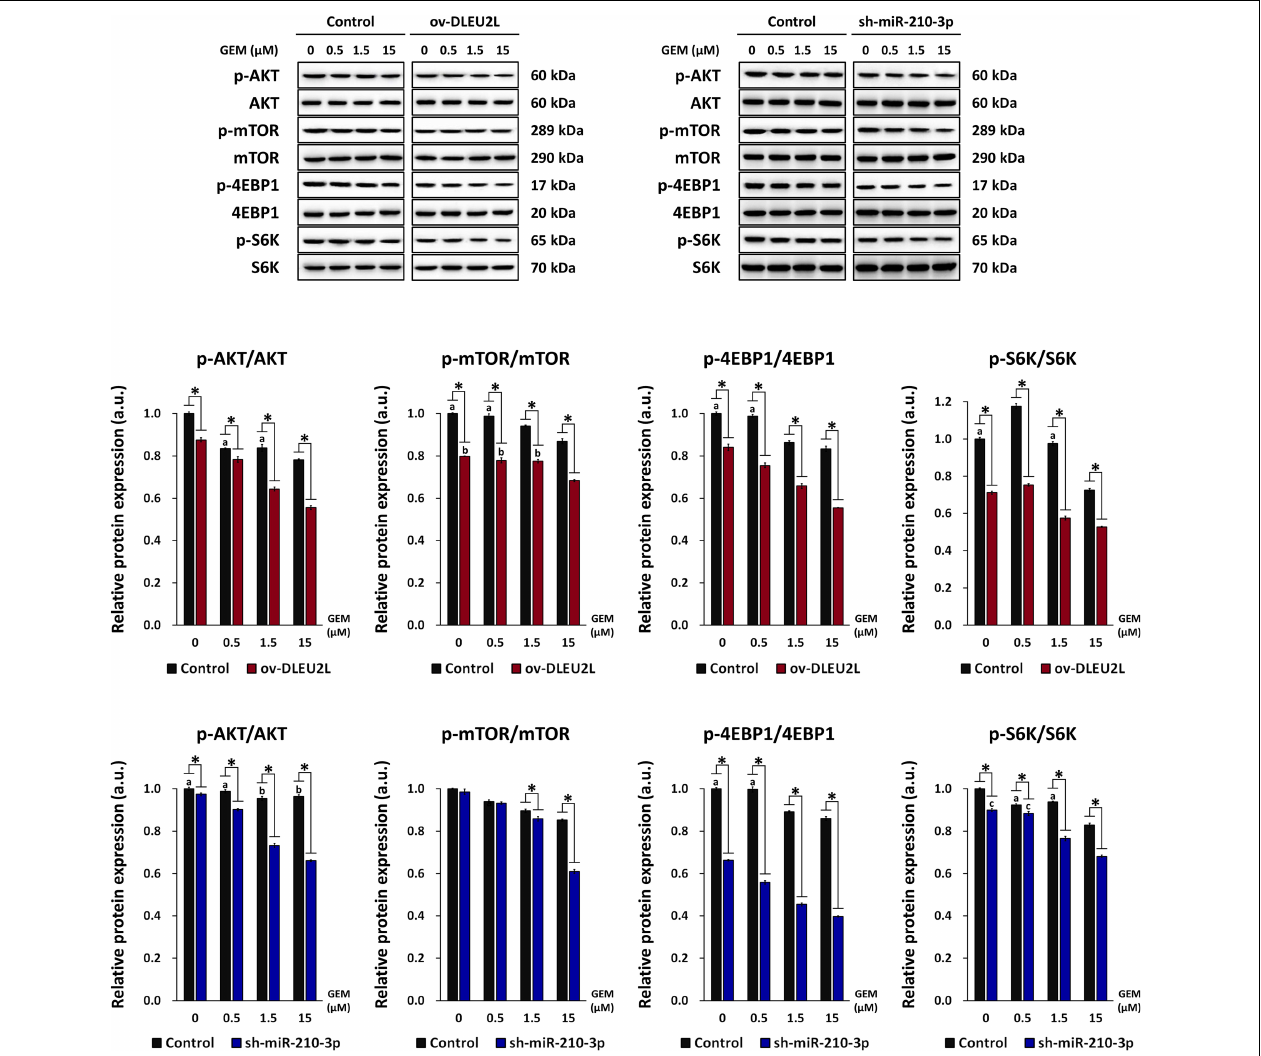
FIGURE 4 | Effect of DLEU2L overexpression and miR-210-3p silencing on AKT/mTOR signaling in PANC-1 cells in the presence of GEM. Western blot and quantification of the expression of proteins associated with AKT/mTOR signaling (phosphorylation of AKT, mTOR, and S6K), in PANC-1 cells transfected with DLEU2L overexpression (ov-DLEU2L) or miR-210-3p interference (sh-miR-210-3p) vectors. Expression of phosphorylated protein was normalized to the respective total protein content. All numerical data are expressed as the mean ± SD ( n = 3); ∗ p < 0.05; data with the same letters are not significantly different ( p > 0.05) in each plot of western blot. Statistical analysis was carried out using